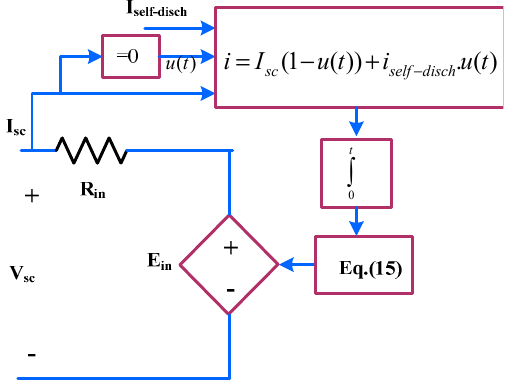
Figure 8. Supercapacitor model.